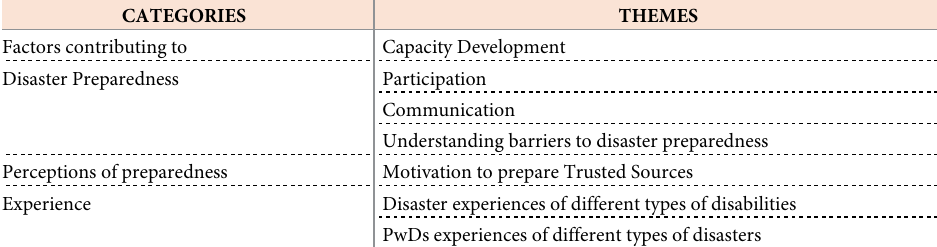
Table 4. Categorises, themes, and sub-themes raised from the